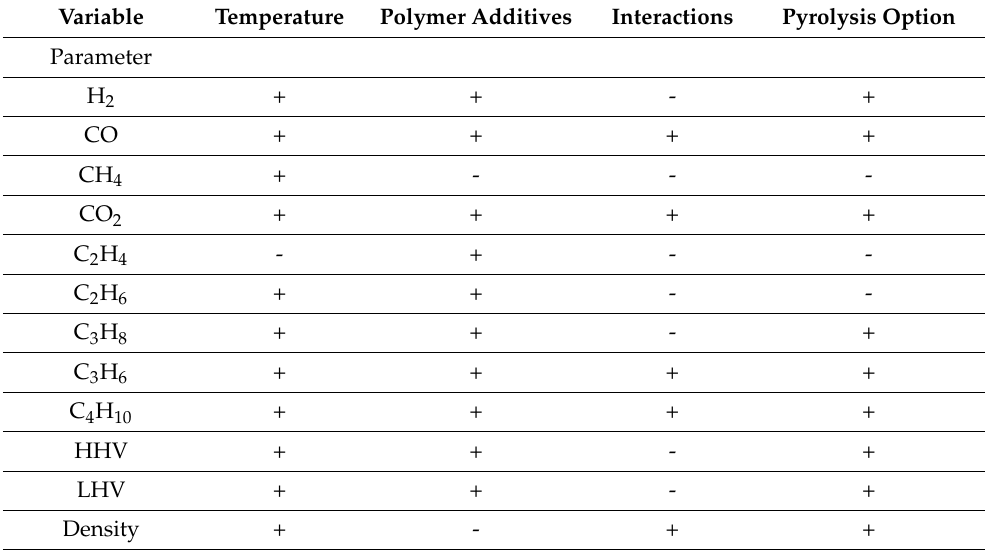
Table 6. Effects of variables on the chemical composition of the gaseous